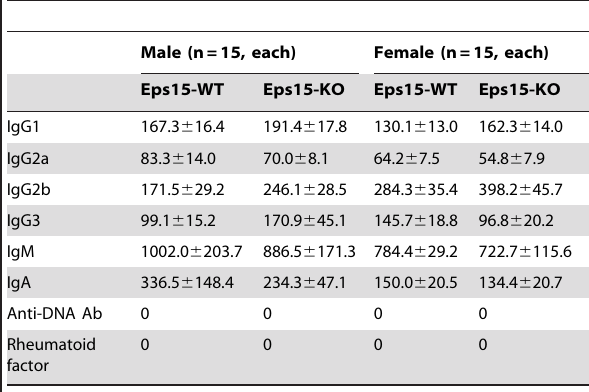
Antibody titers were determined in serum from 12-week old mice.